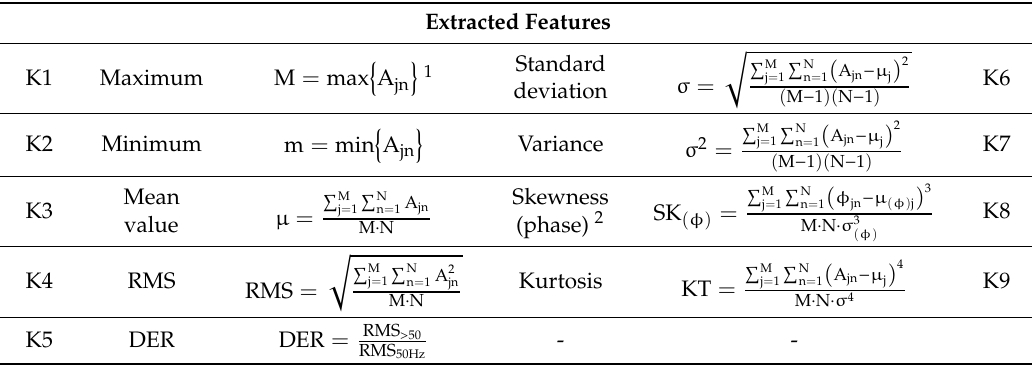
Table 1. Mathematical equations of the initial feature